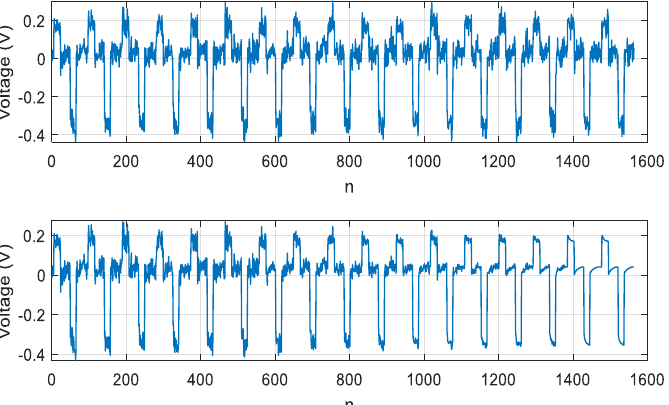
Figure 7. Dependence of extracted signal on discrete time 𝑛 = 𝑡 Δ𝑡⁄ , Δ𝑡 = 1𝜇𝑠, implying an extraction based on skewness.